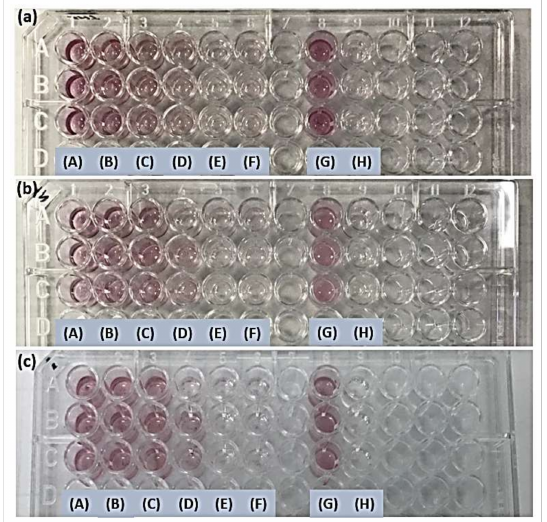
Figure 5. The colour changes of C. albicans after treatment with ( A ) 5 µ g/mL, ( B ) 10 µ g/mL, ( C ) 20 µ g/mL, ( D ) 40 µ g/mL, ( E ) 80 µ g/mL, and ( F ) 160 µ g/mL of ZnO NPs, compared to a negative control ( G ), and a positive control ( H ), ( a – c ) three sets of